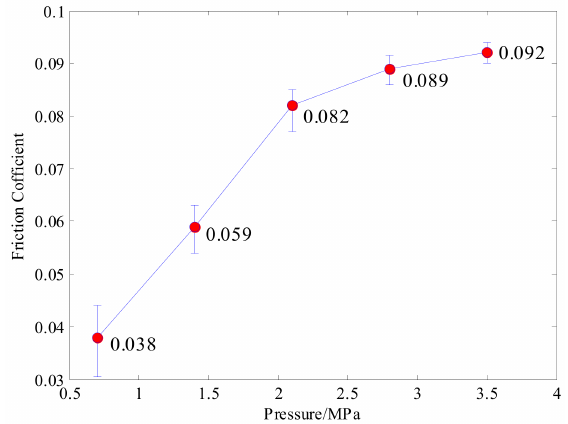
Figure 4. Friction coefficient versus